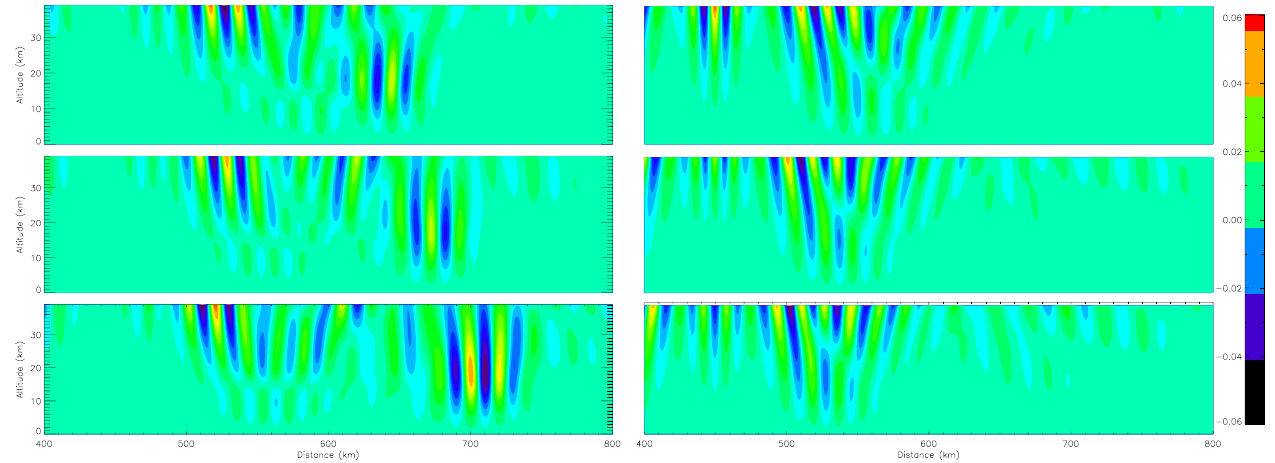
Fig. 5. Vertical velocity simulation results. The left column shows the results of the simulation with a Doppler duct located at ∼ 15-km for three progressively increasing time intervals of 12000-s/3.33-hr, 14000-s/3.89-hr, and 16000-s/4.44-hr. The right column shows the results from the simulation without a Doppler duct at the same time intervals. Color-bar units are in m/sec.